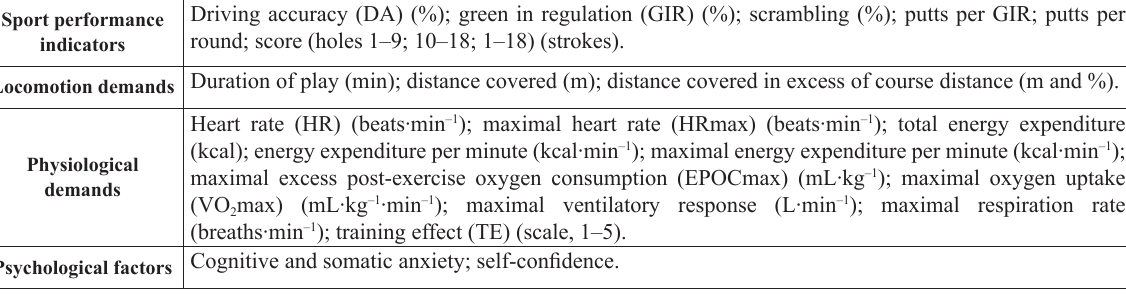
Table 1. Sport Performance Indicators, Locomotion and Physiological Demands, Pre-Competitive Psychological Factors Sport performance